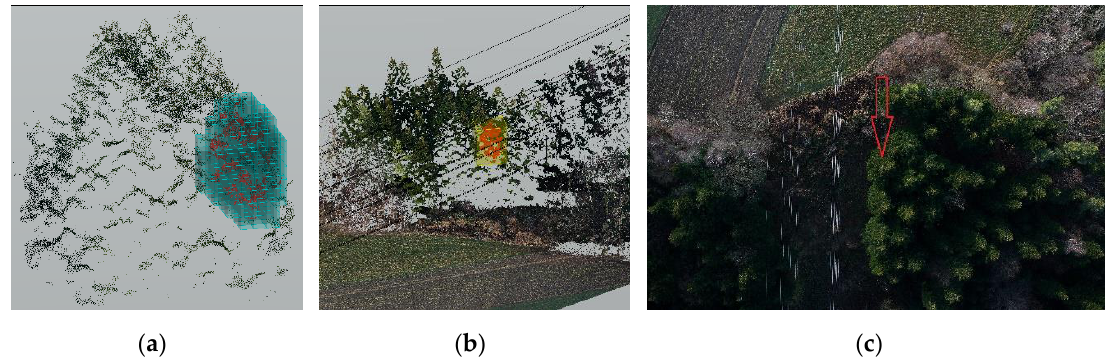
Figure 13. Detected occlusion—positioned at 49°55′09.3′’N, 20°43′09.2′’E with a volume of 39.25 m 3 . A close look at a point cloud with voxels containing occlusion ( a ), bounding box containing the object with a point cloud representation of DSM ( b ), and source image with an arrow pointing to the detected occlusion ( c ).